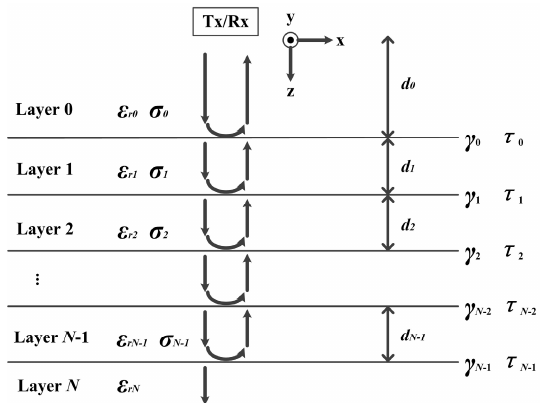
d are, respectively, the  ,  , i i , r i  and  are reflection and transmission i i